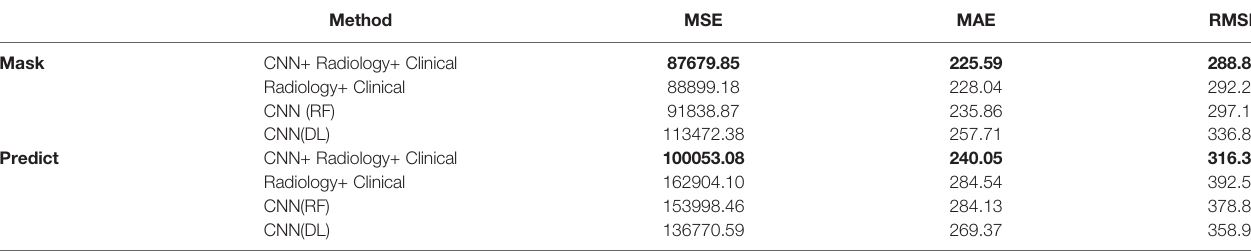
TABLE 5 | Survival prediction results of different types of feature on BraTS